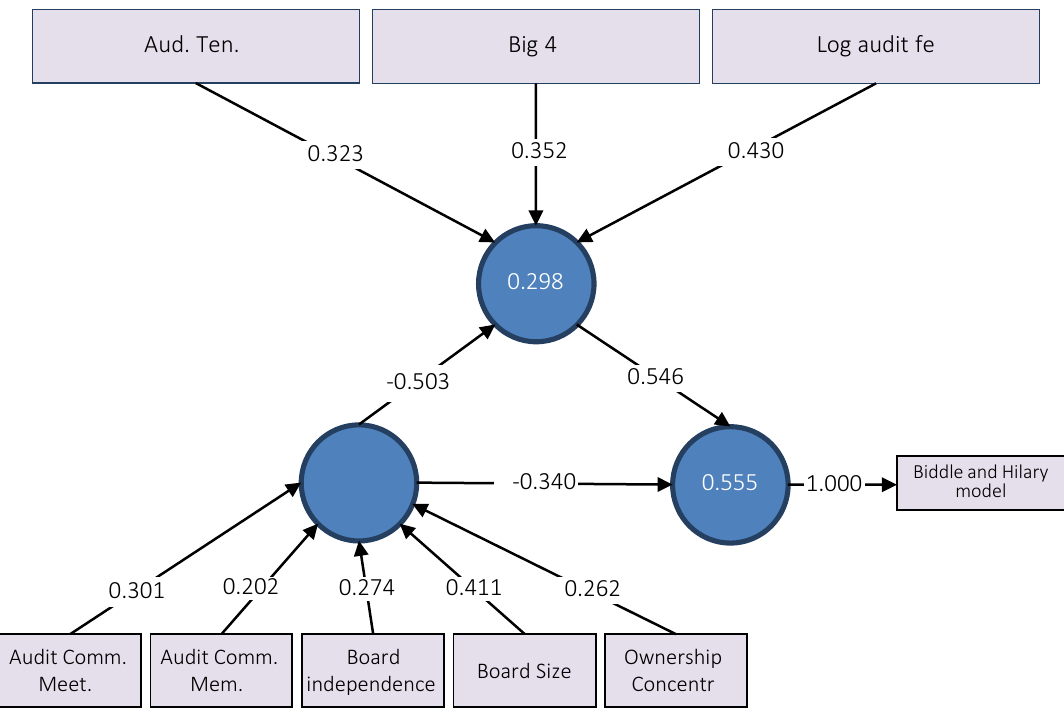
Figure 2. Structural model (outer model), OVERINV